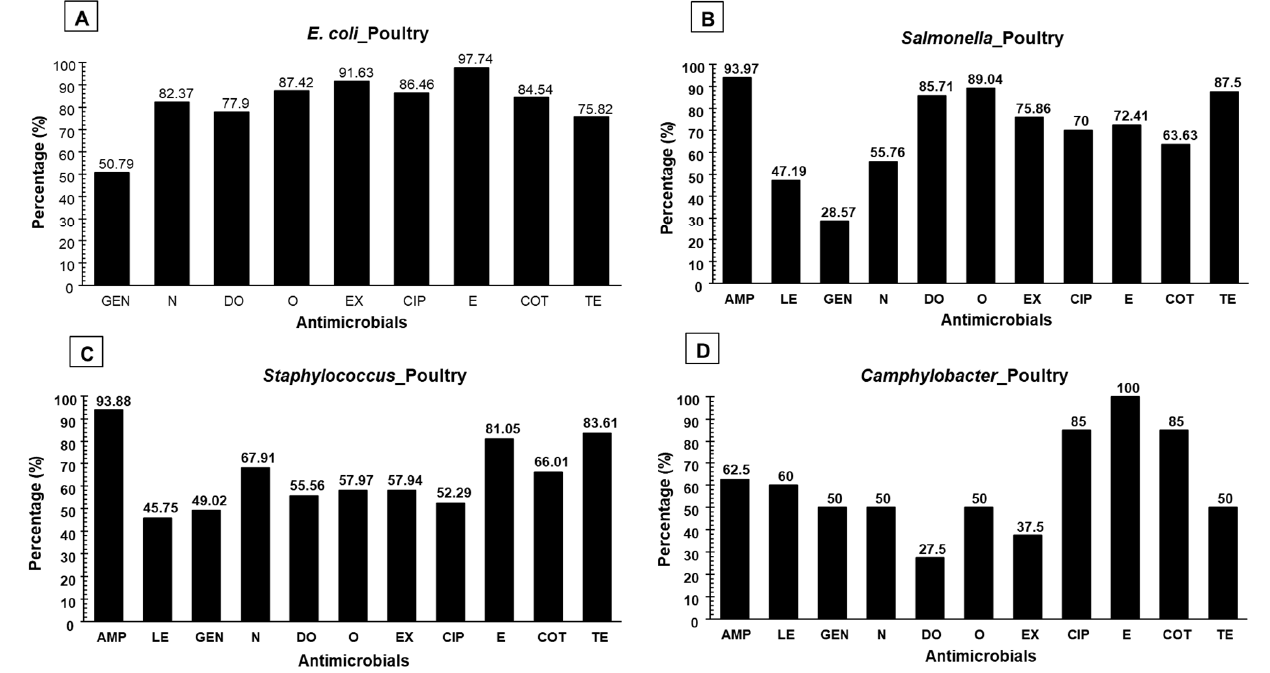
Figure 2. Phenotypic resistance pattern to various antimicrobial agents, AST pattern of ( A ) E. coli , ( B ) Salmonella , ( C ) Staphylococcus , and ( D ) Campylobacter recovered from poultry food products & by-products.